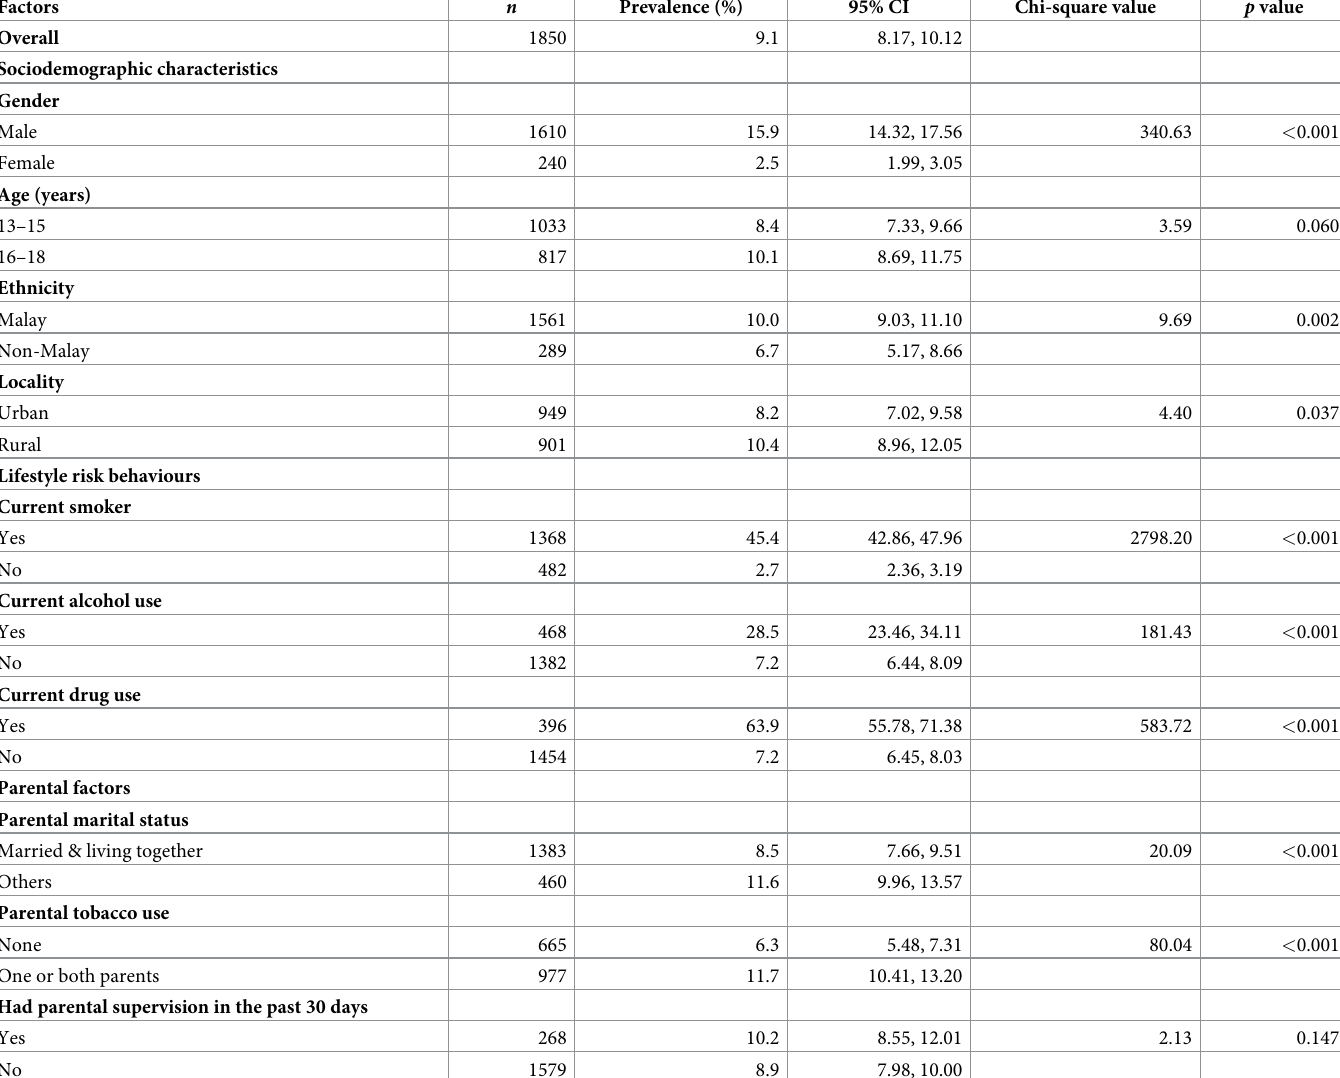
Table 2. Prevalence of current e-cigarette use according to sociodemographic characteristics, lifestyle risk behaviours and parental factors among in-school adoles- cents in West Malaysia.